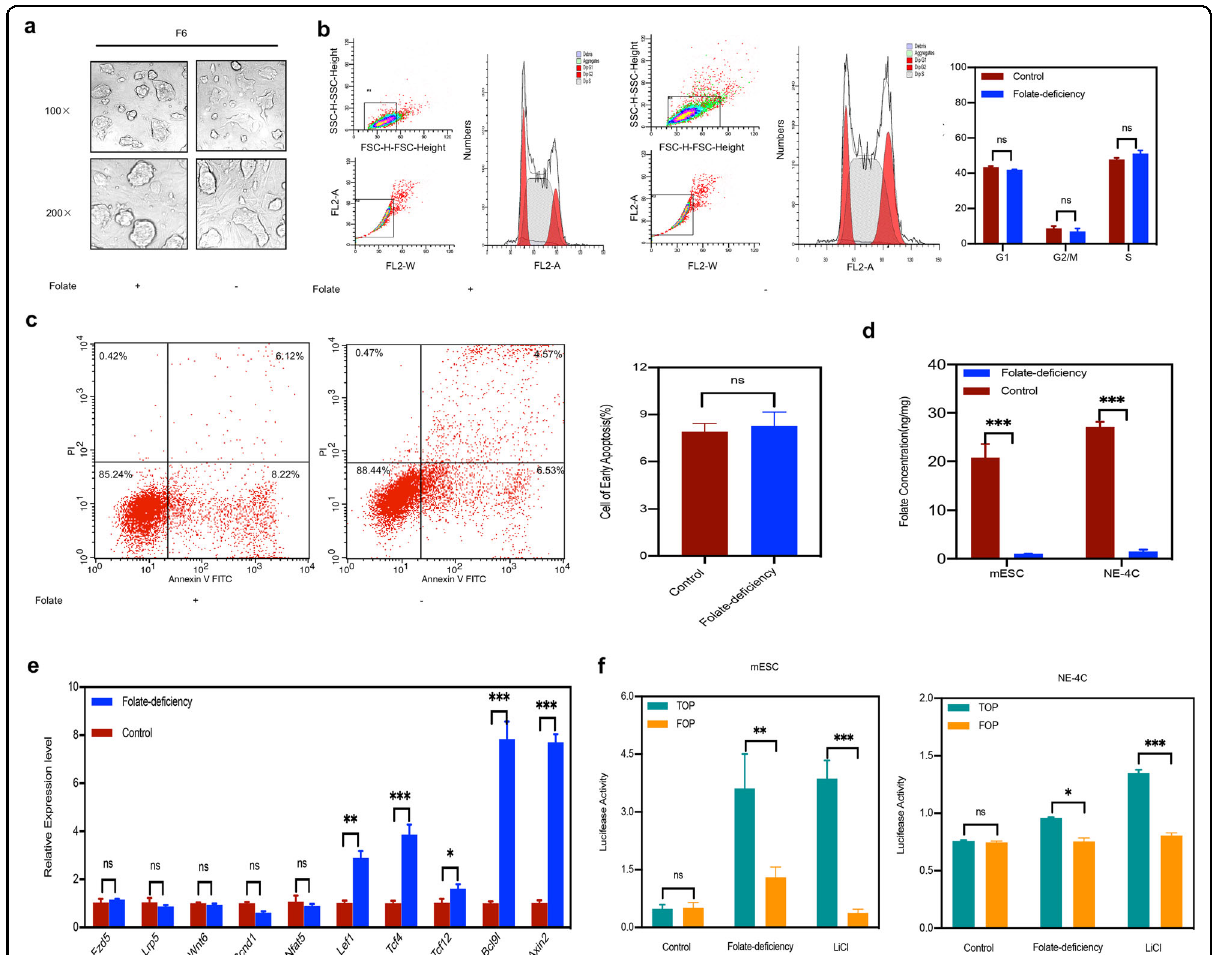
Fig. 1 Wnt/ β -catenin pathway signaling activation in cells with folate de fi ciency. a Morphology of C57BL/6 mESCs as observed with an optical microscope at magni fi cations of ×100 and ×200, F6, sixth generation of C57BL/6 mESCs. b Analysis of the cell cycle distribution of C57BL/6